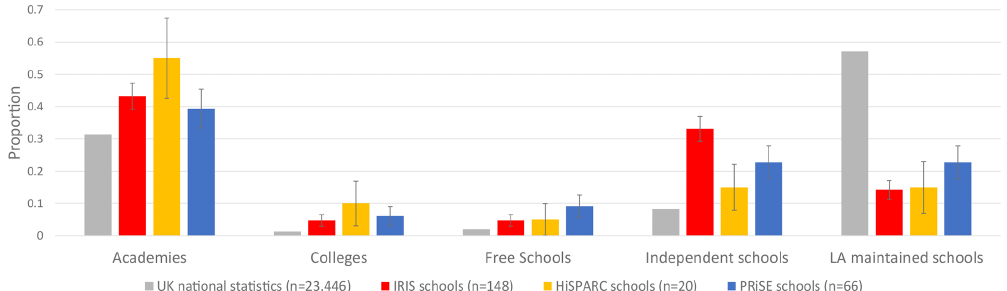
Figure 2. Distribution of school categories involved in IRIS (red), HiSPARC (yellow) and PRiSE (blue) projects compared to UK national statistics (grey). Error bars denote standard Clopper and Pearson (1934) intervals.